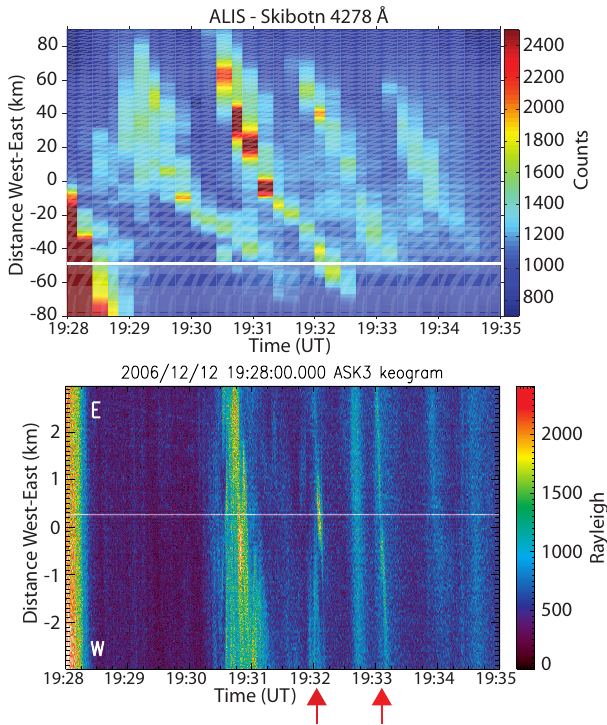
Fig. 1. Top panel: east-west keogram from the ALIS imager in Fig. 1. Top panel: East-west keogram from the ALIS imager in Skibotn, for the time interval 19:28–19:35UT. Bottom panel: east- Skibotn, for the time interval 19:28 - 19:35 UT. Bottom panel: East- west ASK keogram from the same time interval. The white lines west ASK keogram from the same time interval. The white lines mark the position of the EISCAT beam at 107km mark the position of the EISCAT beam at 107 km altitude.